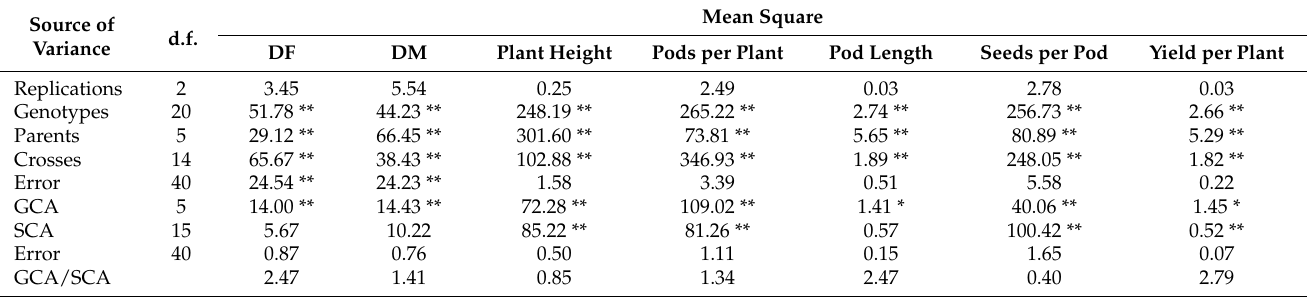
Table 1. Analysis of variance for combining ability of different plant characters in